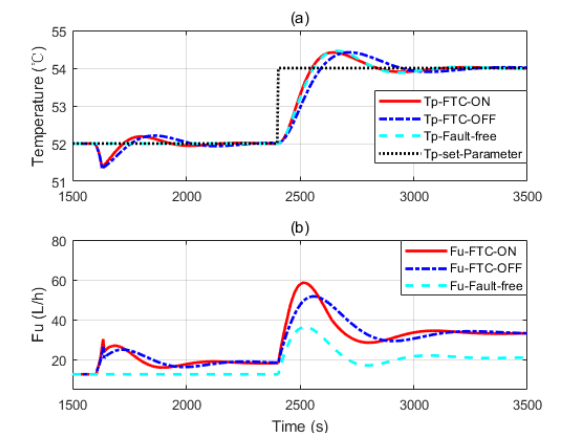
Figure 10. ( a , b ) The simulation considering a faulty parameter dropping to 45% of its nominal value.